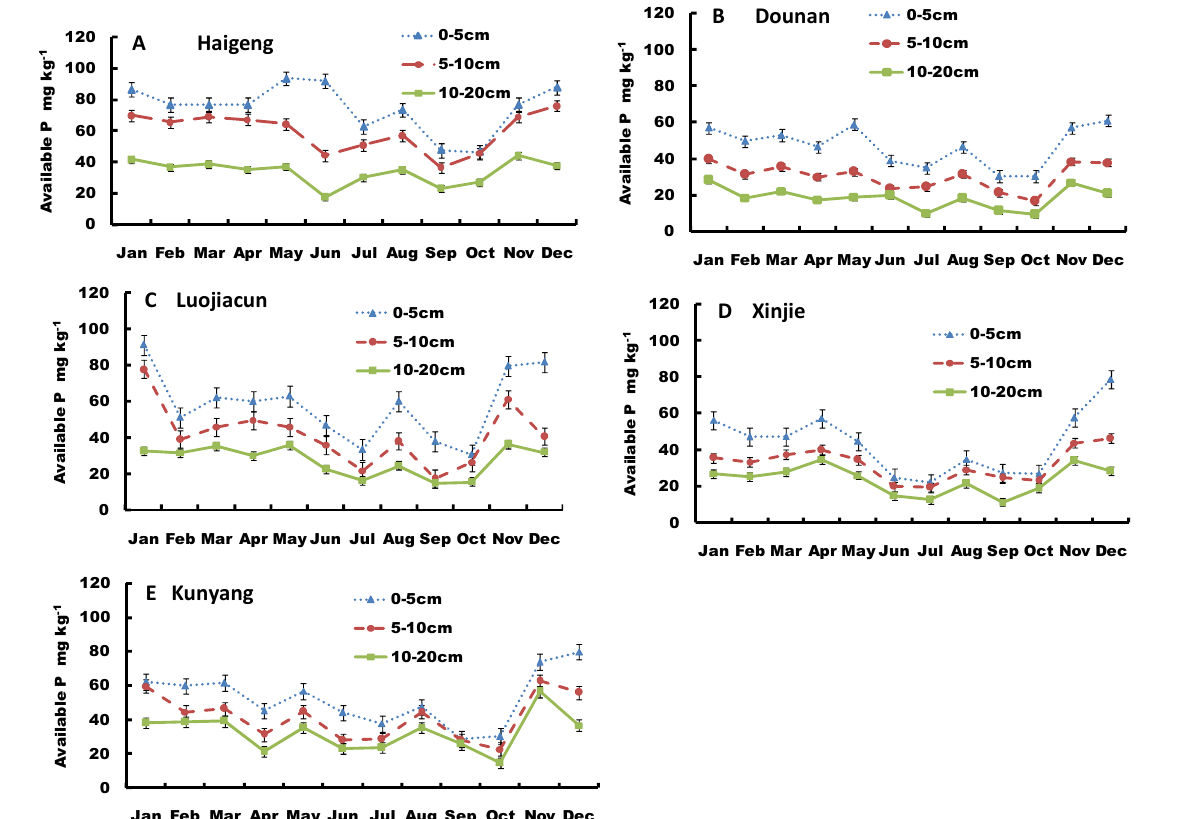
Figure 2. ( A – E ) Monthly variation in sediment available-P (S-AP) at different sites of Dianchi Lake. In the Xinjie site (Figure 2D), sediment available-P concentrations were also ordered: surface > middle > bottom, at 15.1–78.8 mg kg − 1 , 19.4–46.4 mg kg − 1 , and 11.43–34.9 mg kg − 1 , respectively. Variance in the surface sediment was higher than in the middle and bottom layers, ranging from 28% to